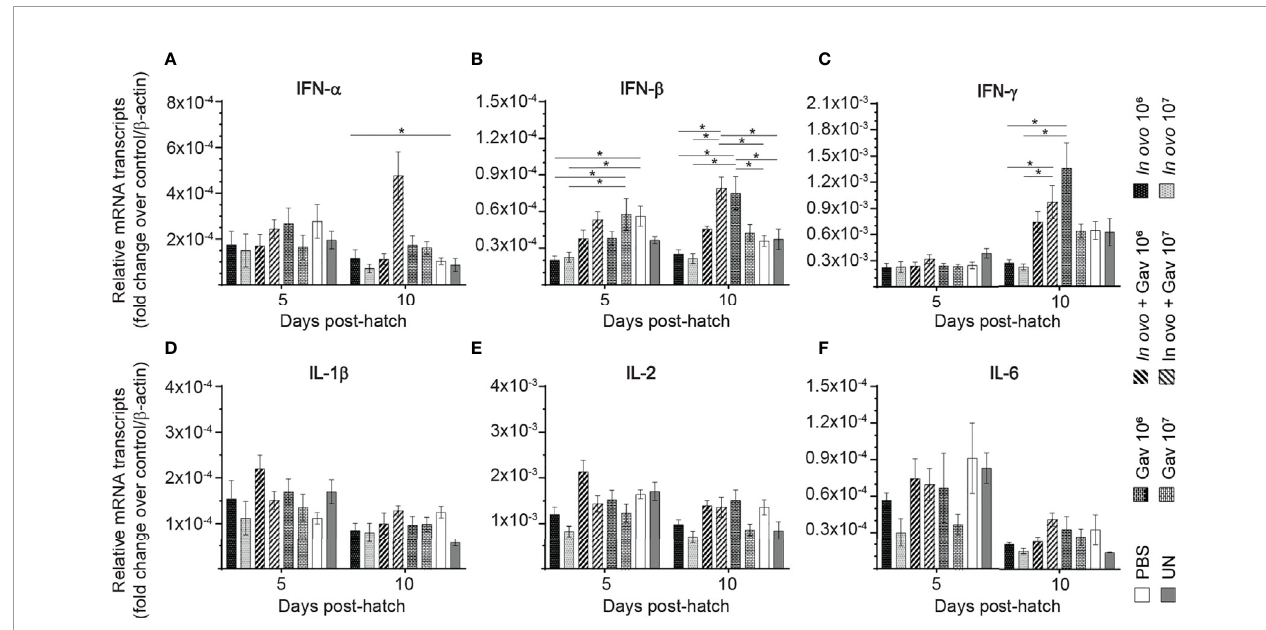
FIGURE 1 | Relative gene expression in the spleen of chickens inoculated with lactobacilli. Spleen samples were collected at days 5 and 10 post-hatch from all treatment groups: groups 1 and 2 received 10 6 and 10 7 CFUs of lactobacilli cocktail in ovo , respectively, at embryonic day eighteen; groups 3 and 4 received 10 6 and 10 7 CFUs of lactobacilli, respectively, via both in ovo and oral gavage (on days 1, 7, 14, 21, 28 post-hatch); groups 5 and 6 received 10 6 and 10 7 CFUs of lactobacilli, respectively, via oral gavage; group 7 was served as a negative control group and was injected with phosphate-buffered saline (PBS); group 8 remained untreated (UN). Fold change was used to characterize differences in gene expression of IFN- a , IFN- b , IFN- g , IL-1 b , IL-2 and IL-6 (A – F) , in comparison to negative control group. Statistical signi fi cance among treatment groups was calculated using SAS Proc GLM (General Linear Model) followed by Tukey ’ s comparison test. Error bars represent standard errors of the mean. Results were considered statistically signi fi cant if P < 0.05. Bars with asterisks represent a signi fi cant difference among treatments. The data are representative samples from 6 individual